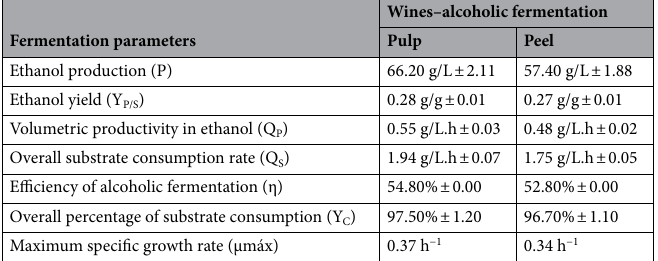
peel. In Table 3 (GAE: gallic acid equivalent, TE: trolox equivalents (Trolox-Equivalent Antioxidant Capacity), ABTS: 2,2’-azino-bis(3-ethylbenzothiazoline-6-sulfonic acid), DPPH: 2,2-Diphenyl-1-picrylhydrazyl, FRAP: ferric reducing antioxidant power, nd: not detected, < DL: values below detection limit, L*: luminosity, a*[(−) green to (+) red] and b* [(−) blue to + yellow] chromaticity coordinates, ho, Hue angle and C*, Chromaticity, ΔE: Total color difference. Different letters on the same line differ statistically at the 95% confidence interval ( p < 0.05). Pulp and peel wines had pH values of 3.94 (pulp) and 3.69 (peel) and titratable acidity expressed in acetic acid of 0.76 g/100 mL (pulp) and 0 0.46 g/100 mL (peel). Final pH values between 3.5 and 4.0 were reported